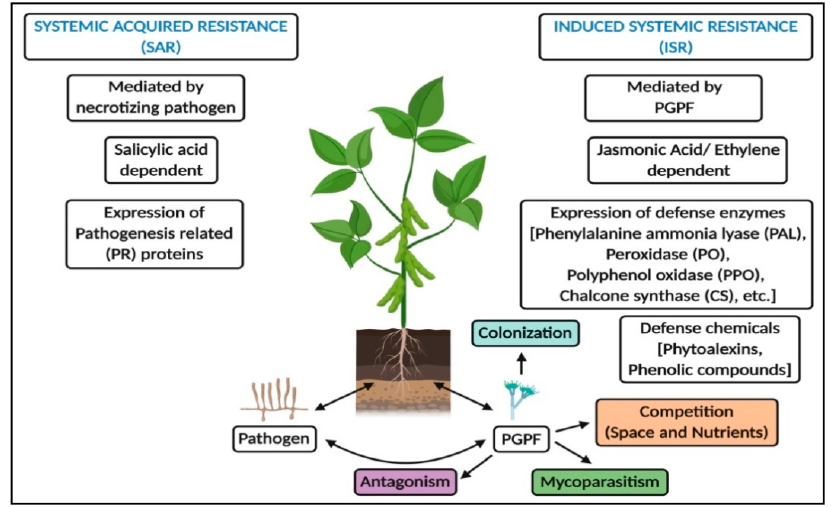
Figure 2. Mechanism of resistance offered by PGPF against the invading pathogens.